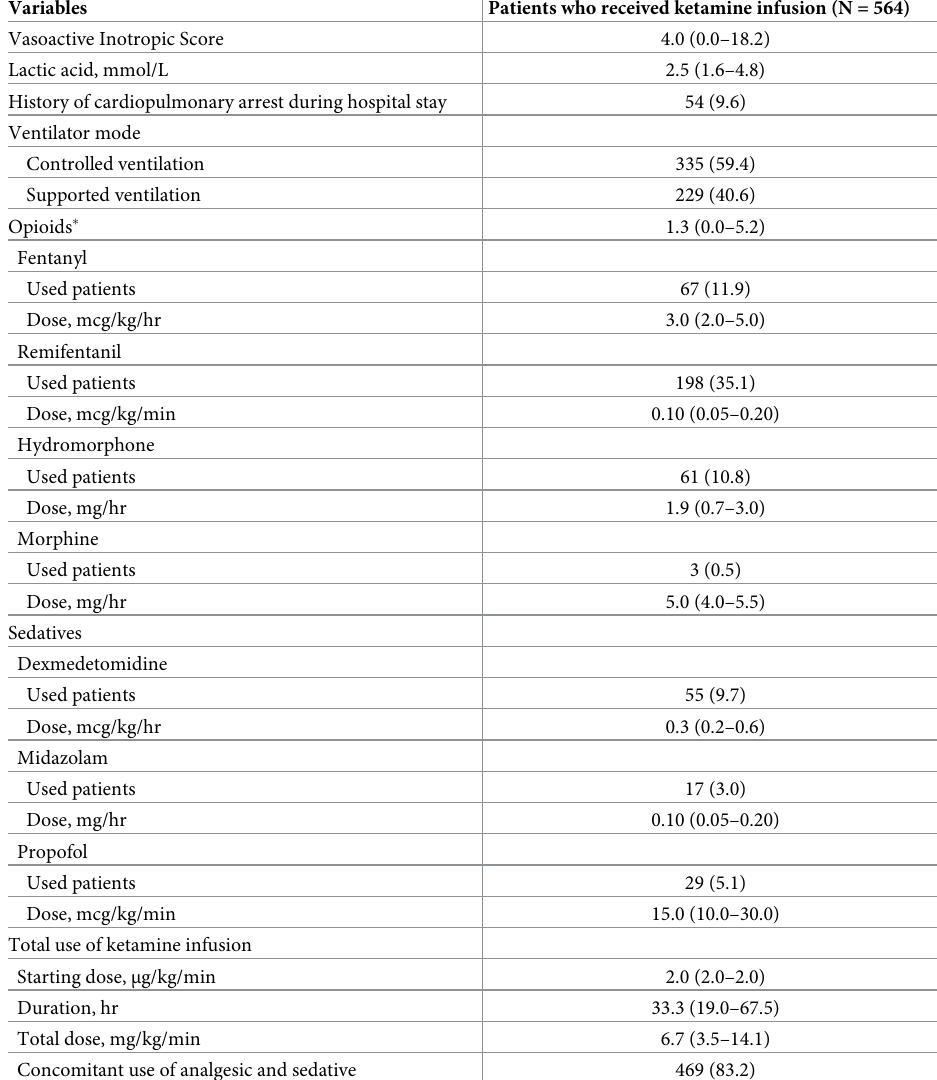
Table 2. Characteristics at the start of continuous ketamine